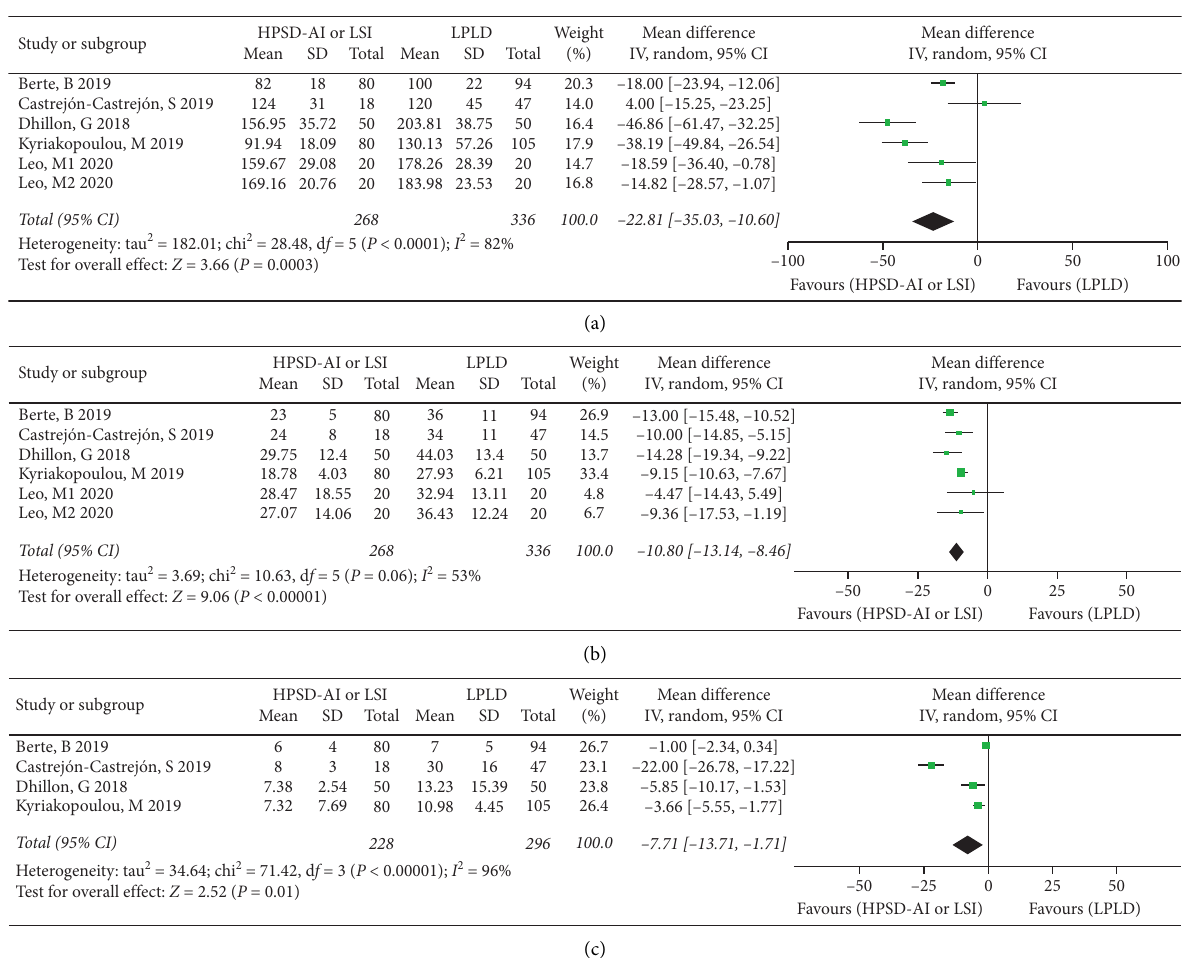
Figure 3: Forest plot displaying procedural efficiency. (a) Procedure duration, (b) radiofrequency duration, and (c) fluoroscope